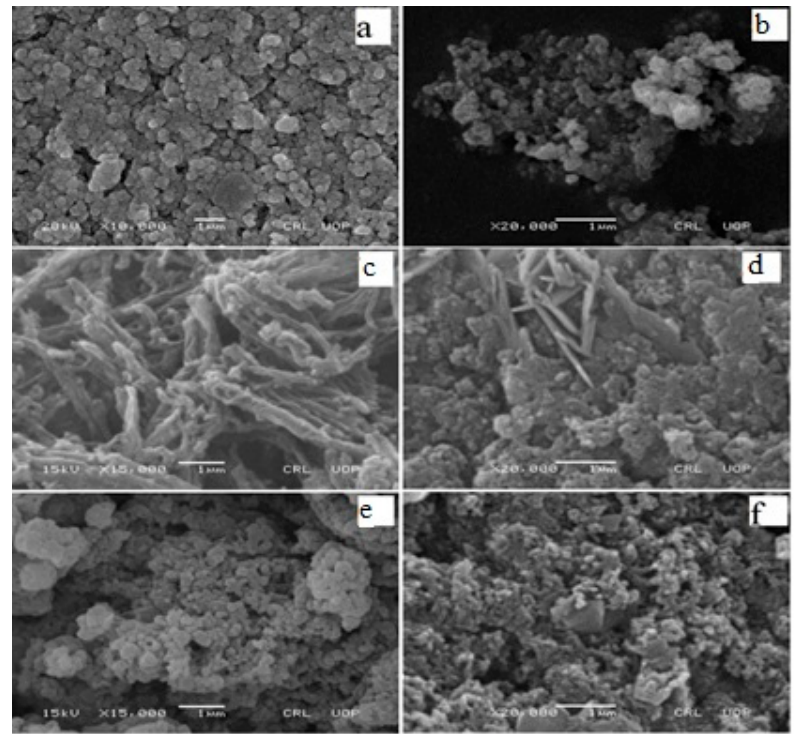
Figure 1. SEM images of magnetic oxide (Fe 3 O 4 ), polyaniline (PANI) and PANI/Fe 3 O 4 composite before ( a , c , e ) and after ( b , d , f ) adsorption of acid blue 40 (AB40) dye.